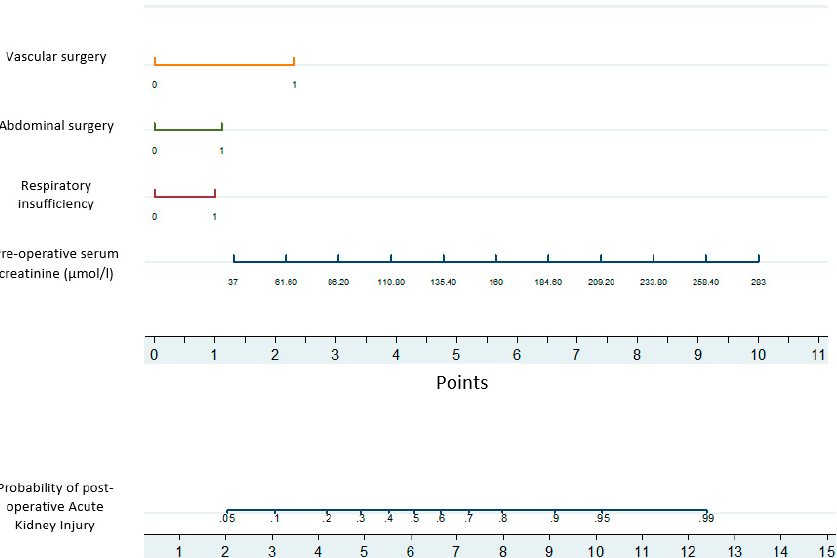
Figure 3. Nomogram indicating the number of points associated with each risk factor. Note: The number of points were found by drawing a vertical line from the value of the risk factor (0 = absent, 1 = present) to the X-axis. For example, if the patient had vascular surgery, the corresponding number of points is 2.5, and if creatinine was 110 µ mol/L, then another four points was added to the patient’s score, yielding a total score of 6.5, and a probability of 50% experiencing post-operative AKI.